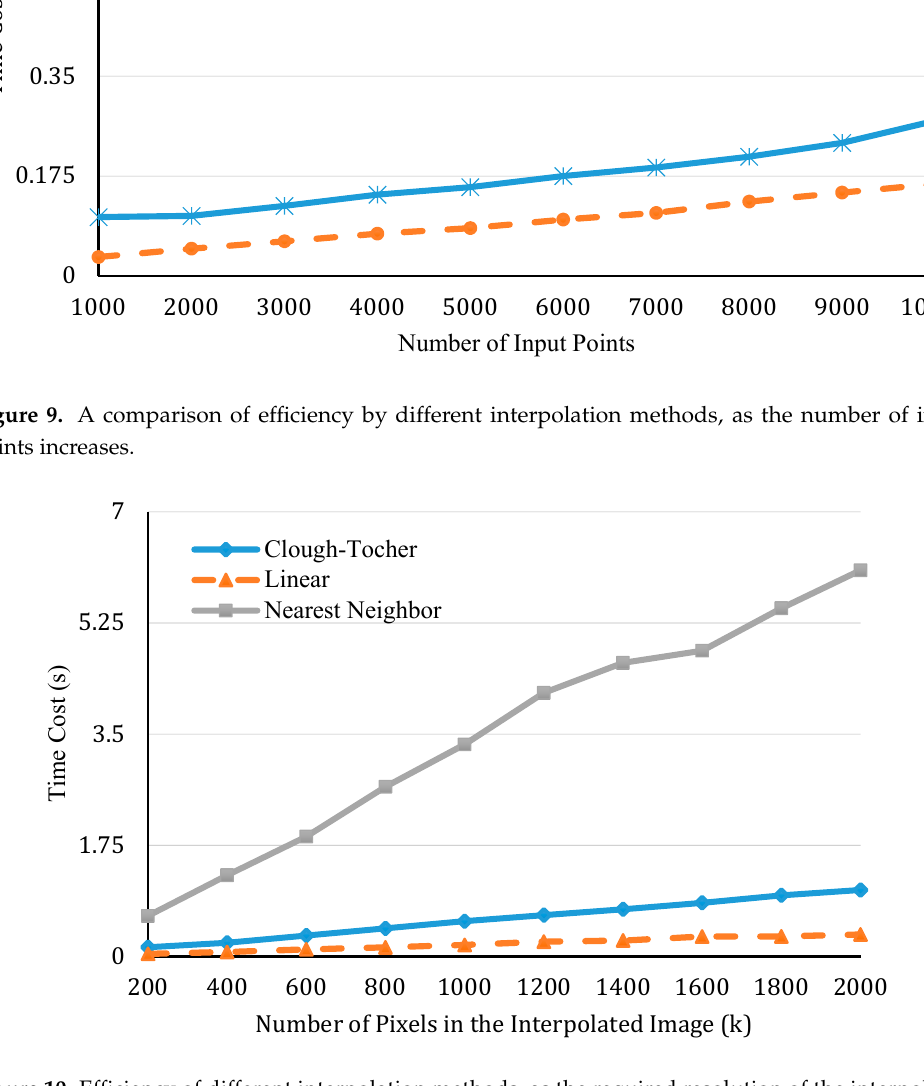
Figure 10. Efficiency of different interpolation methods, as the required resolution of the interpolated image increases.